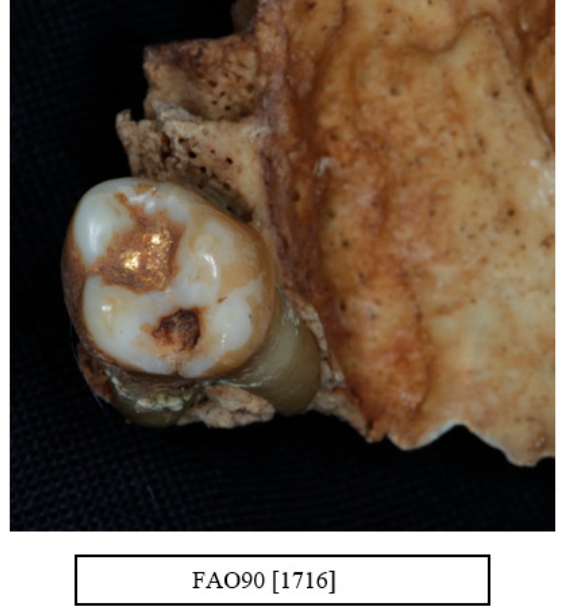
Figure 11 . One individual presented with a gold restoration in a maxillary molar tooth, which appeared to be the only sign of any dental treatment other than extraction (courtesy of the Museum of London).